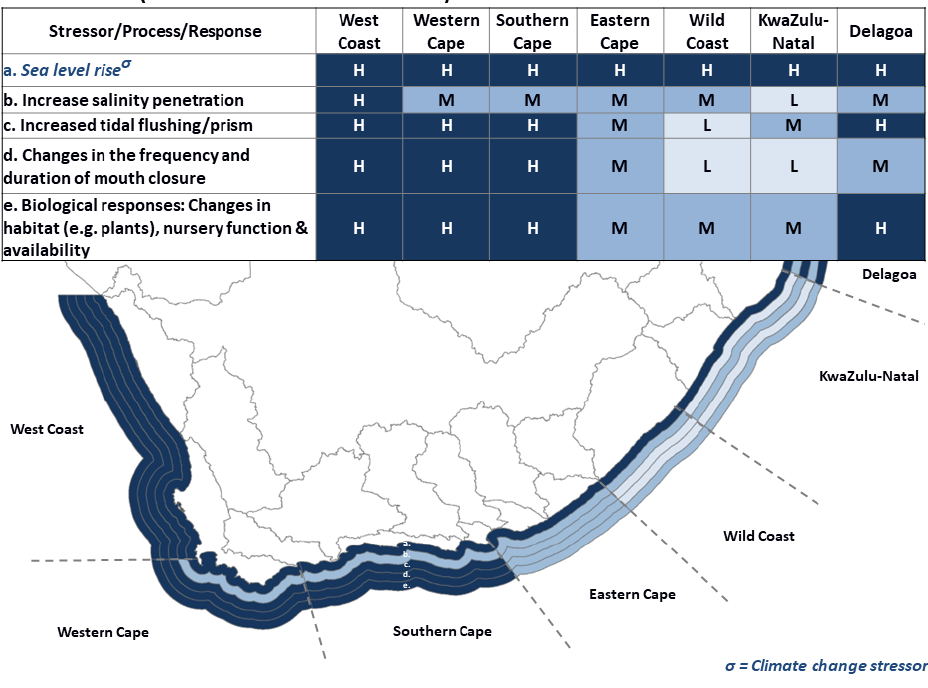
Figure 4. Summary of vulnerability ranking (high/medium/low) for estuaries in seven regions associated with sea level rise (colour zones on map depict ( a ) to ( e ) in table moving outward from the coast with H = high, M = medium, L = low).